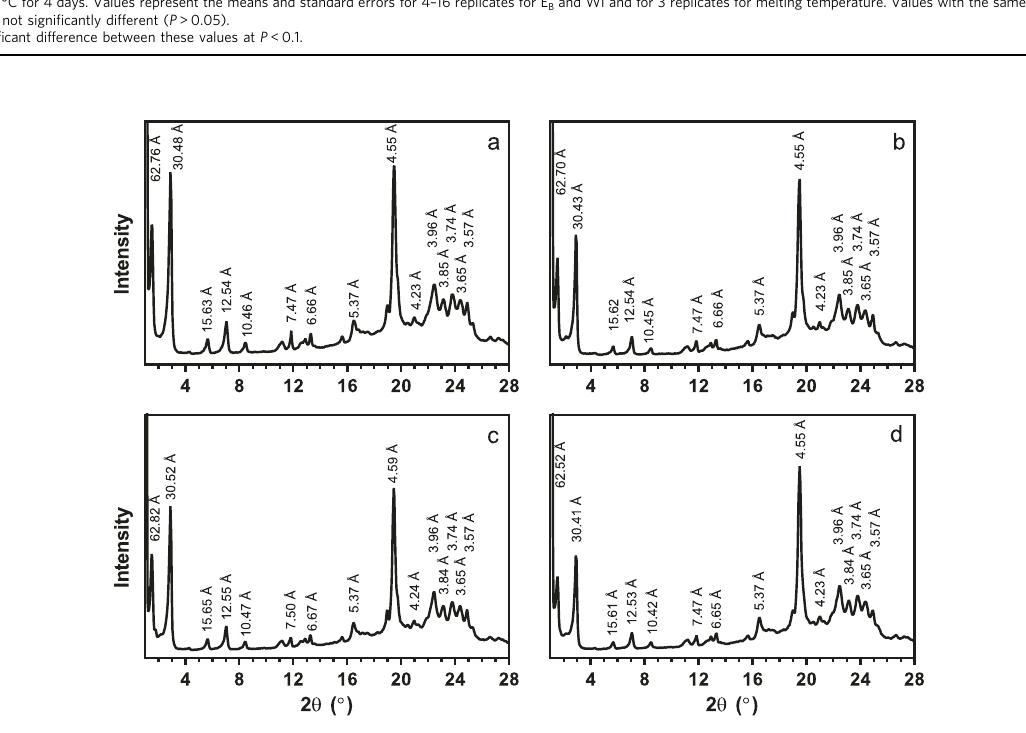
Fig. 5 Powder X-ray diffraction patterns for commercial chocolate with added minor lipidic components. Chocolate samples were molten, blended with the minor components and crystallized at 5 °C for 1 h, followed by 20 °C for 4 days. The a commercial chocolate, b molten and recrystallized commercial chocolate, c molten and recrystallized commercial chocolate with added 0.1% (w/w) dimyristoylphosphatidylcholine, and d molten and recrystallized commercial chocolate with added 0.1% (w/w) dipalmitoylphosphatidylethanolamine, all display powder X-ray diffraction patterns characteristic of well- tempered β 2 , triclinic, Form V cocoa butter crystals. This crystal form displays a strong re fl ection corresponding to a short spacing of ~4.6 Å in the wide- angle diffraction region, and characteristic wide-angle re fl ections in the 2 θ region 20 – 25°. In the small-angle diffraction region, only re fl ections from the 3 L (001) plane corresponding to ~62 – 63-Å were observed. The absence of re fl ections from (001) plane of the 2 L polytype indicates the formation of the optimal polytypic form in the cocoa butter in all samples. Re fl ections at higher angles in the small-angle region correspond to higher-order re fl ections for these two crystal